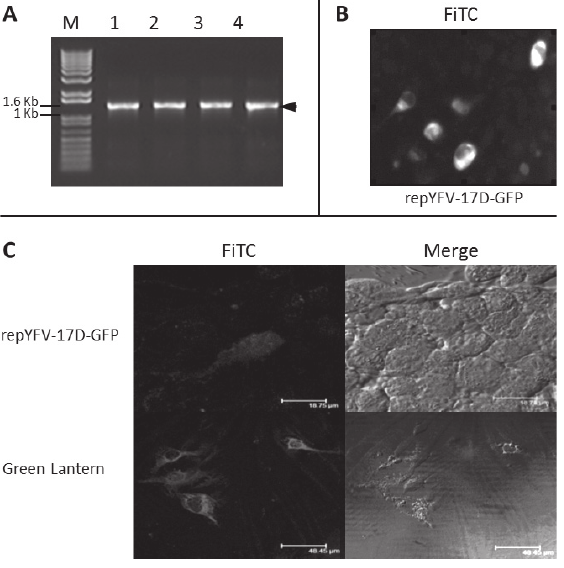
Figure 3 - Characterization of the subgenomic replicon repYFV-17D- Luc. (A) Confirmation of the cloning of four clones repYFV-17D-Luc by homologous recombination in yeast. Agarose gel electrophoresis of the expected PCR product of 2.3 Kb. The numbers correspond to clone tested (1-4). (B) Firelly luciferase activity detected in cell extracts from BHK21 cells electroprated with the replicon rep-YFV-17D-Luc during seven days post-electroporation. (C) Detection of protein expression of yellow fever virus by indirect immunofluorescence of BHK21 cells at 48 hours post-electropation with replicon RNA repYFV-17D-Luc in vitro transcribed.